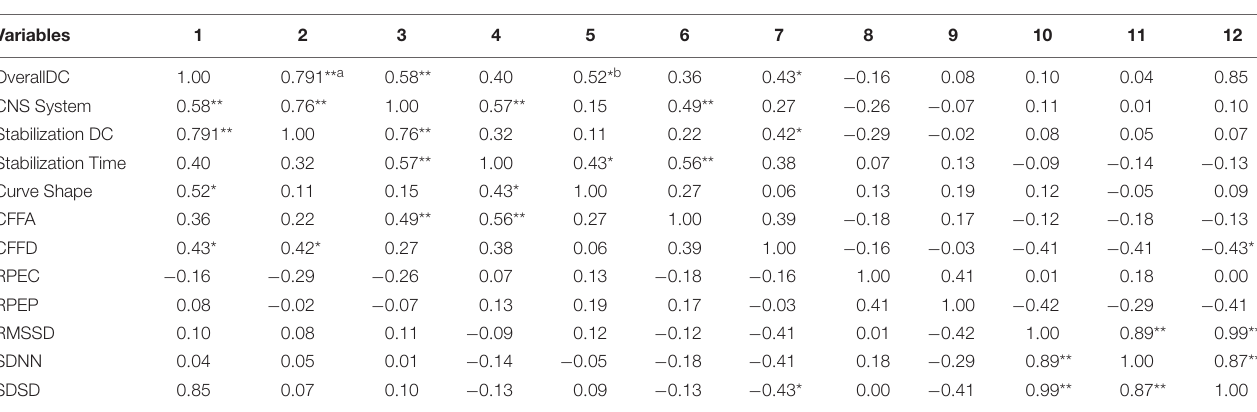
TABLE 3 | Rho Spearman